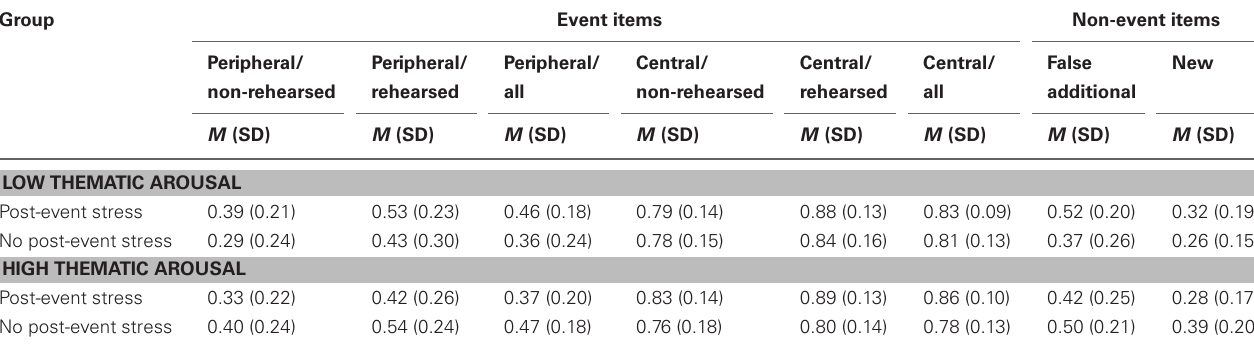
Table 1 | Mean recognition rates (standard deviations) as a function of thematic arousal, post-event stress, and item type.